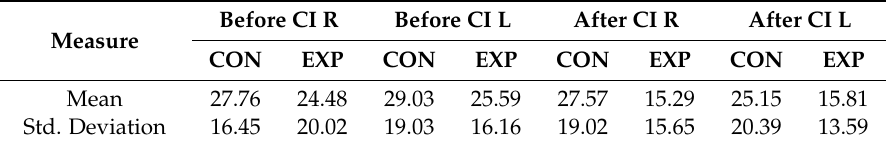
Table 4. Mean values and standard deviations of CI parameter.